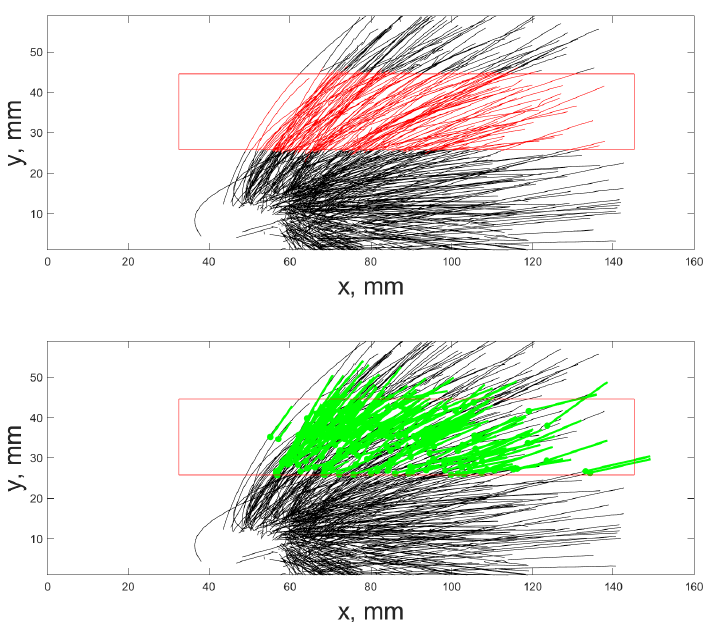
Figure 5. Illustrations of finding trajectories crossing the given search areas and determining average velocities. On the top image, segments of the trajectories crossing the search areas are marked in red. On the bottom image, the green straights corresponded mean velocity length, with denoting of the position (point) of its calculation.